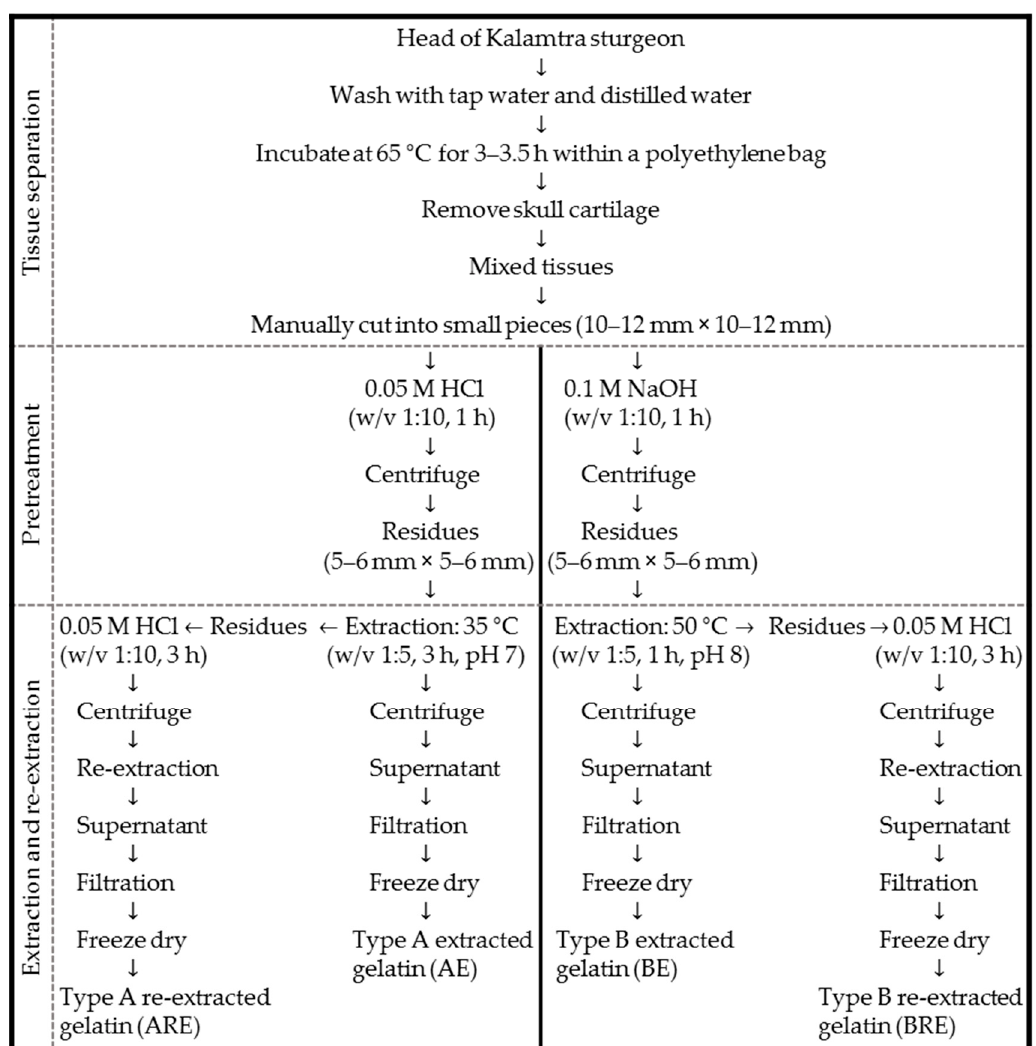
Figure 4. An overview of protocols used for the extraction and re-extraction of type A and type B gelatins from the head of Kalamtra